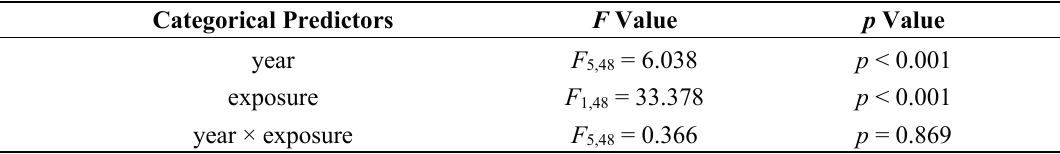
Table 3. Results of the ANOVA analysis on the effect of year and exposure on the ISD ( n = 60). Fisher test and p value are